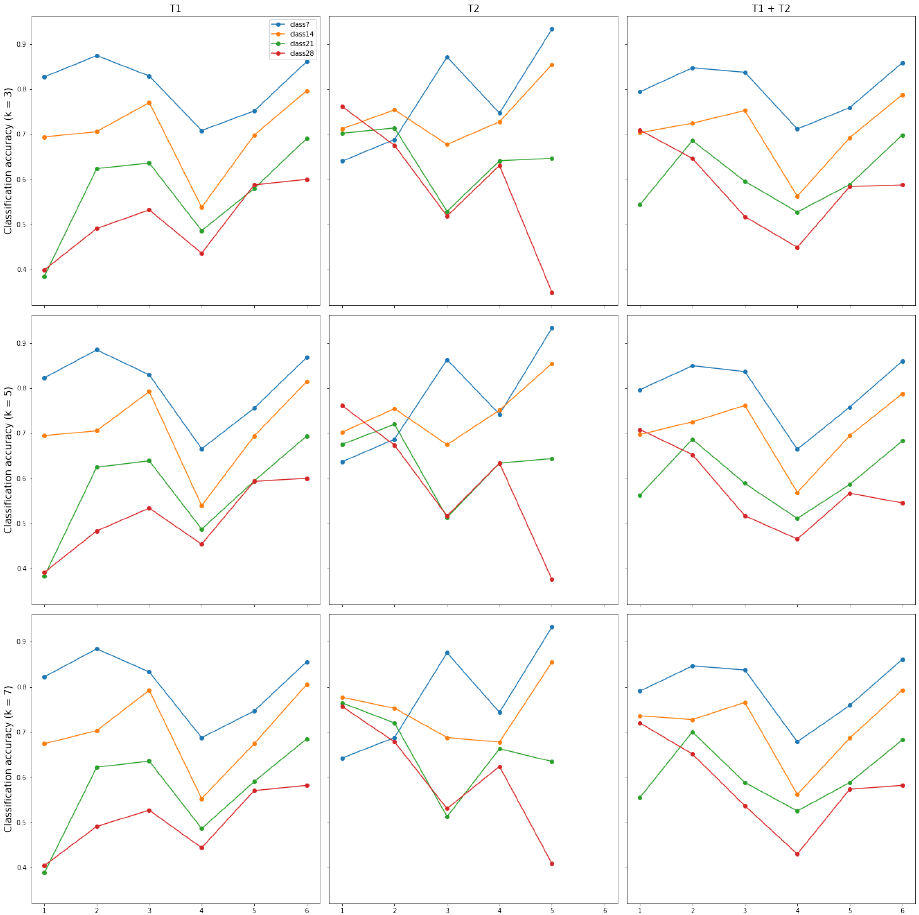
Figure 4. Classification accuracy obtained for various data